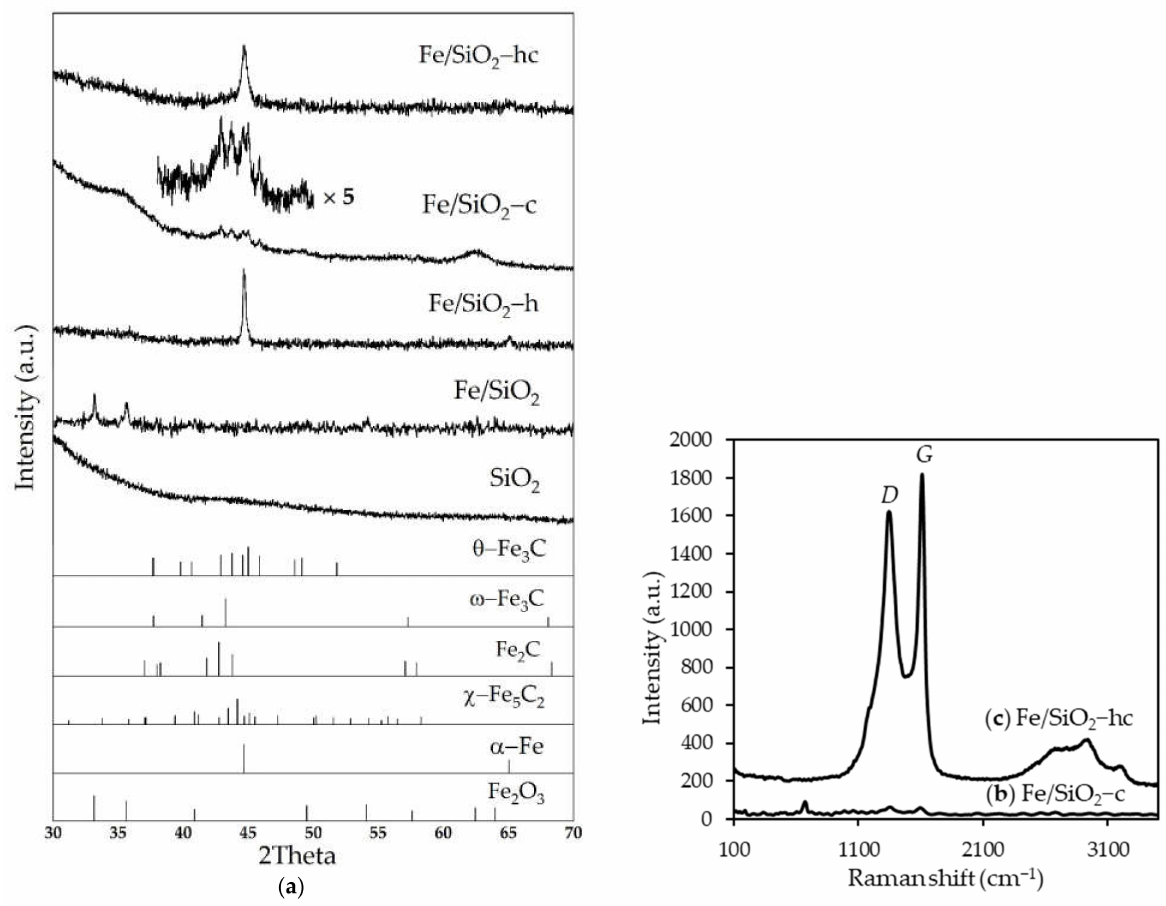
Figure 2. ( a ) XRD profiles of the calcined Fe/SiO 2 catalyst and all activated Fe/SiO 2 catalysts, and